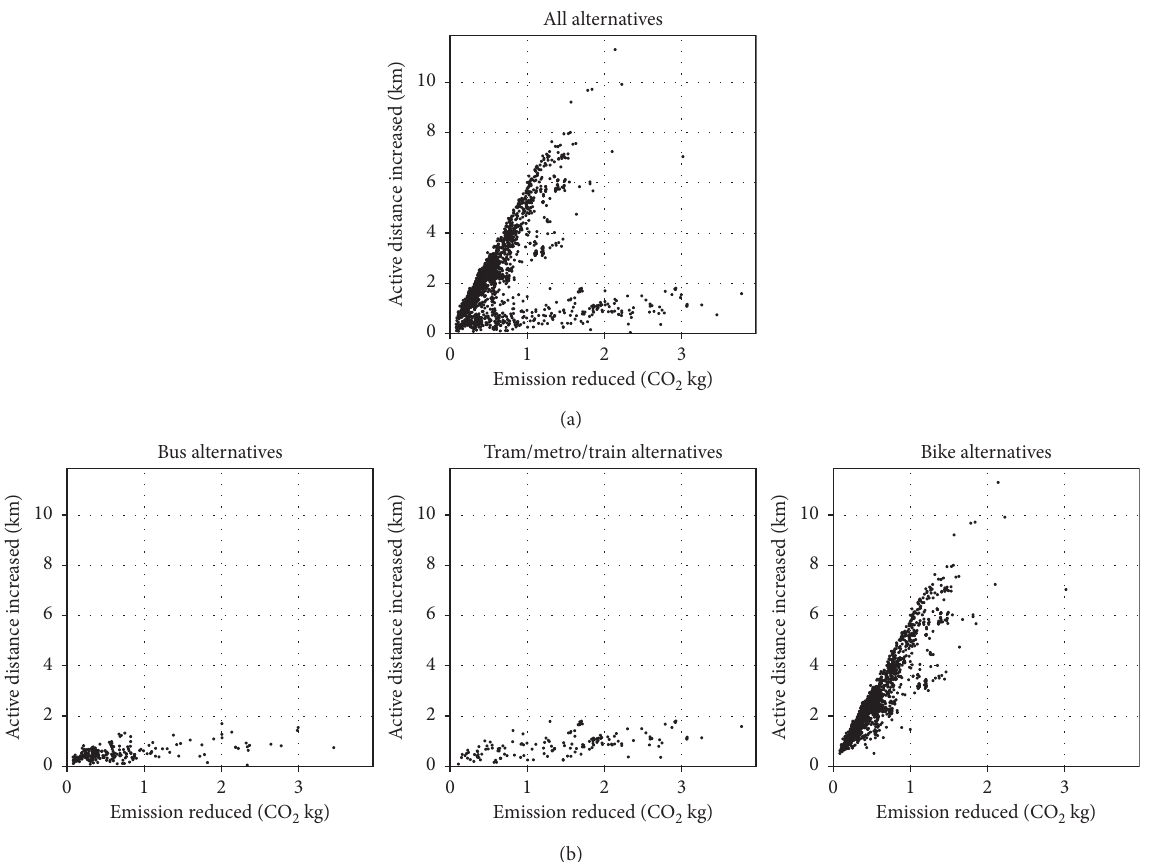
Figure 17: Potential emission savings and active travel increase if travelers shift from car to low-carbon time-relevant alternatives. Each point represents one door-to-door trip. (a) All car trips with any low-carbon alternative. (b) Car trips grouped based on the type of their alternative mode.